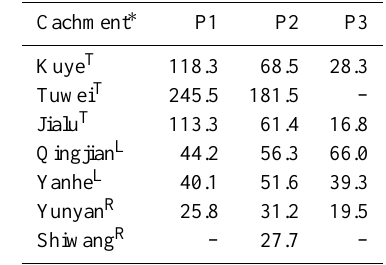
Table 8. Comparison of the standardized streamflow volumes as the catchments reaches their scour and silting balances in the three